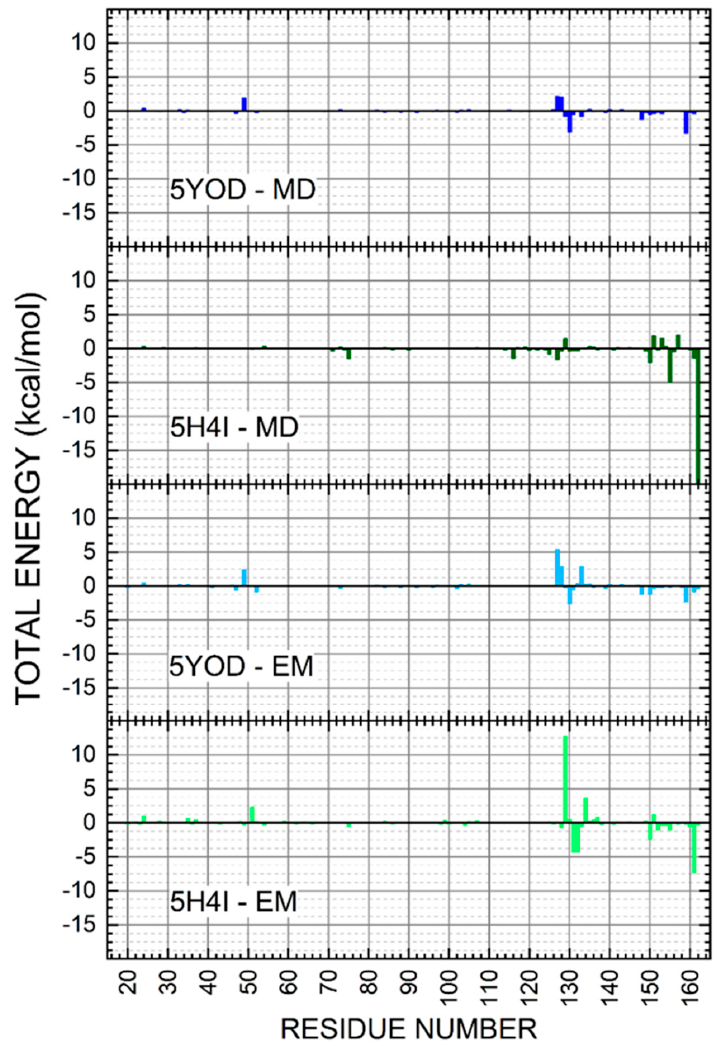
Figure 9. Energy contributions per amino acid residue for the 5YOD (md5/pbsa), 5YOD (em/pbsa), 5H4I (md5/pbsa), and 5H4I (em/pbsa) systems.